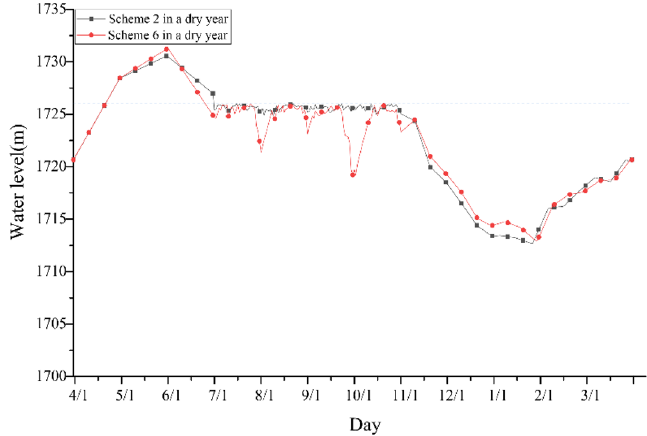
Figure 11. Water level process lines in a dry